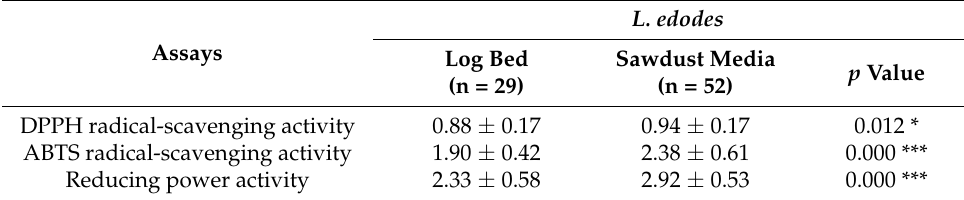
Table 4. IC 50 (mg/mL) properties of the methanolic extracts in Lentinula edodes cultivated on log bed and sawdust